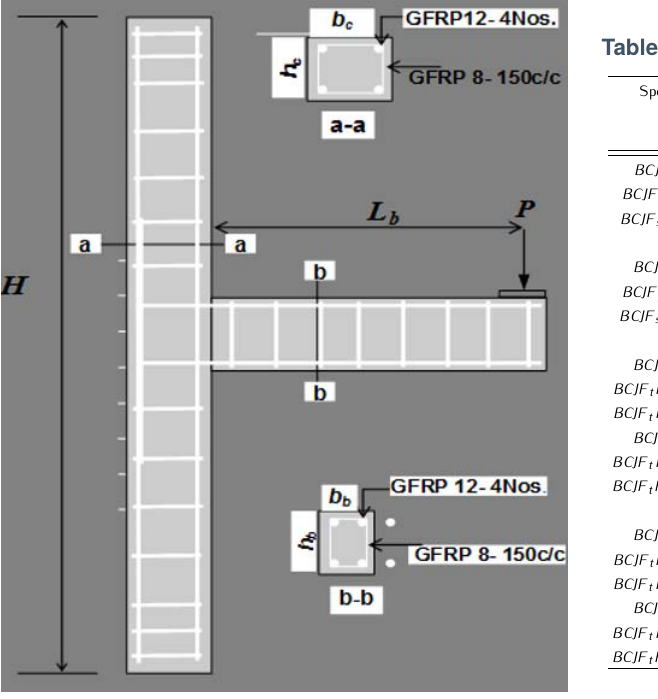
Figure 3. Typical beam-column joint specimen.